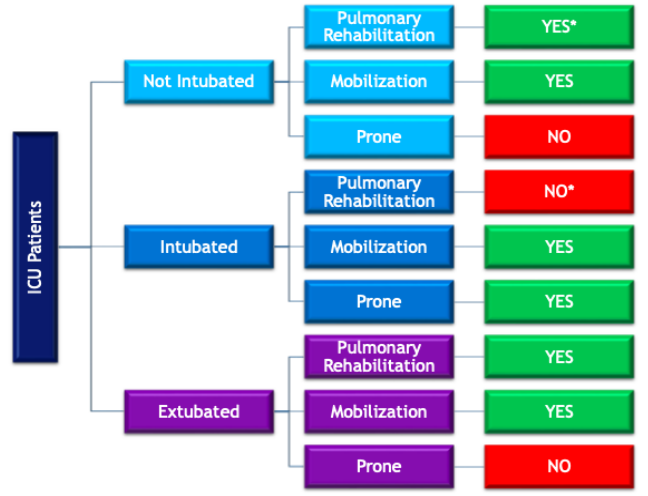
Figure 2. Main topics for the implementation of physical therapy in intensive care unit (ICU) pa- tients with